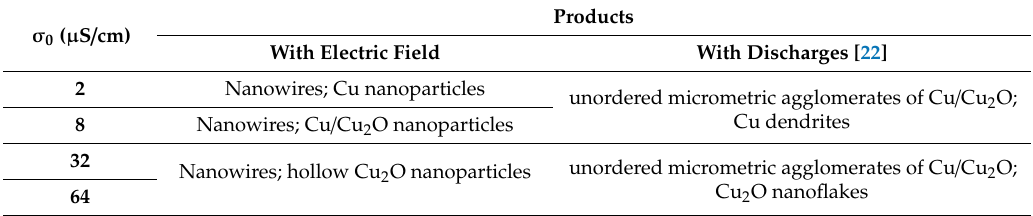
Table 2. Comparison of the main nanomaterials produced by electric field and by discharges under various conditions of water